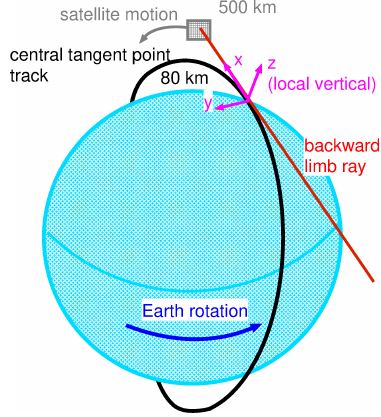
Figure 3. Schematic view of the synthetic orbit and grid